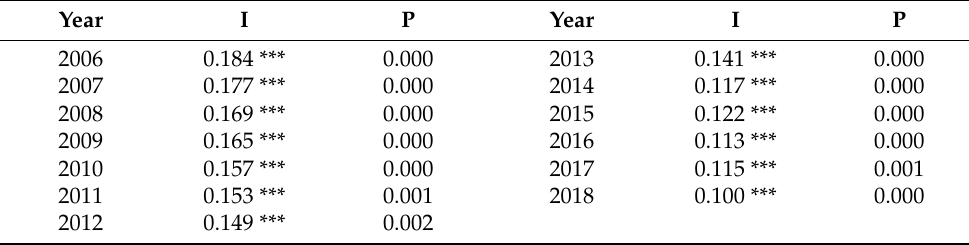
Table A3. Global Moran’s index of MPI.